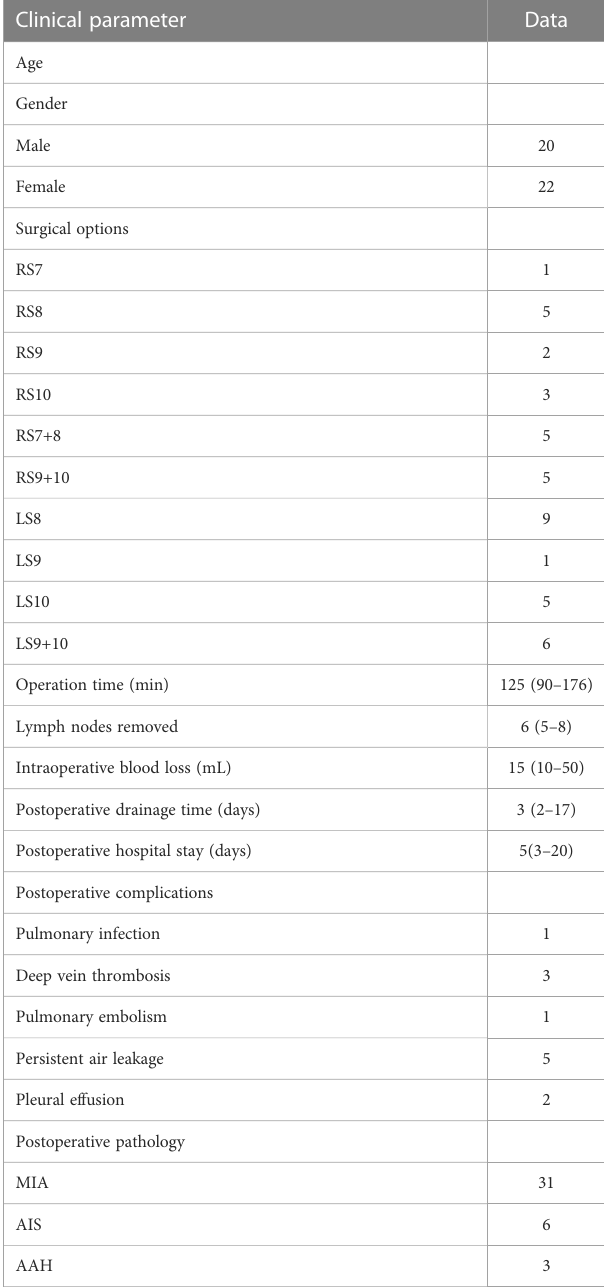
TABLE 1 The speci fi c surgical procedures and other clinical data. Clinical